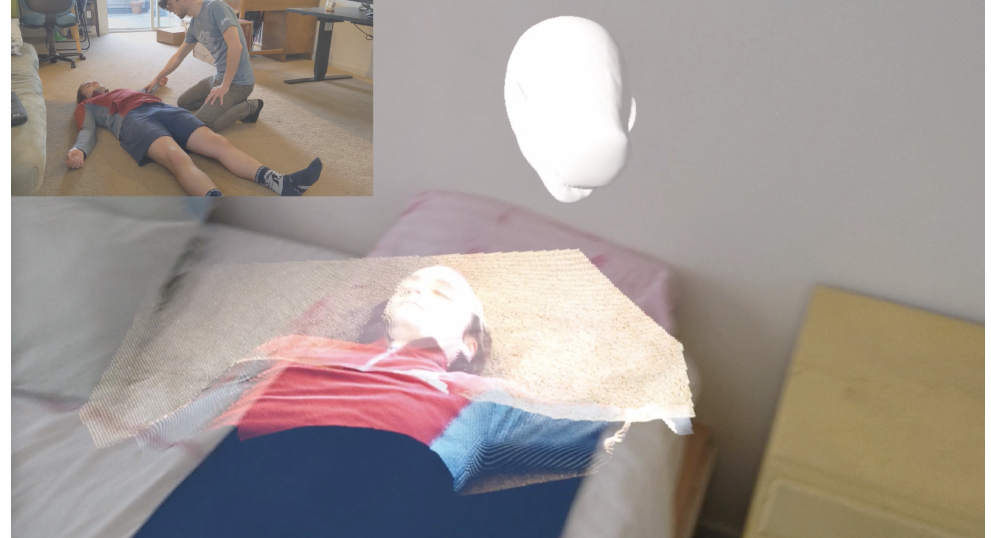
Figure 2. Small image top-left: A trainer (streamer) wearing a HoloLens 2 and looking at a patient. Large image right: A mixed reality capture of the student’s first-person view (receiver) showing the color point cloud of the patient from the perspective of the trainer wearing the HoloLens 2. The white head model represents the head pose of the trainer. A full (video demo, https://youtu.be/oo6A1 yKrJFY, accessed on 22 February 2022) also shows the segmentation of the